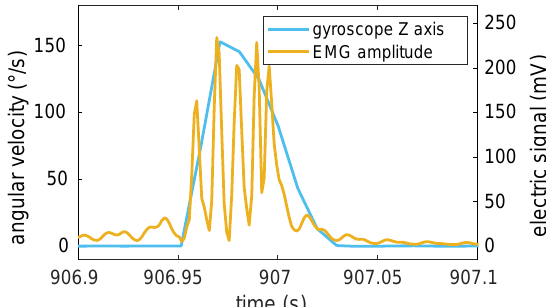
Figure 13. Example of the synchronization between the EMG and the gyroscope sensors. A stimulus causing simultaneous electrical and mechanical excitations of the device was applied after about 15 min of operation. Since the two sensors have independent clocks, without synchronization a drift of several seconds would have accumulated after 15 min. The reclocked signals are instead synchronized to within sampling